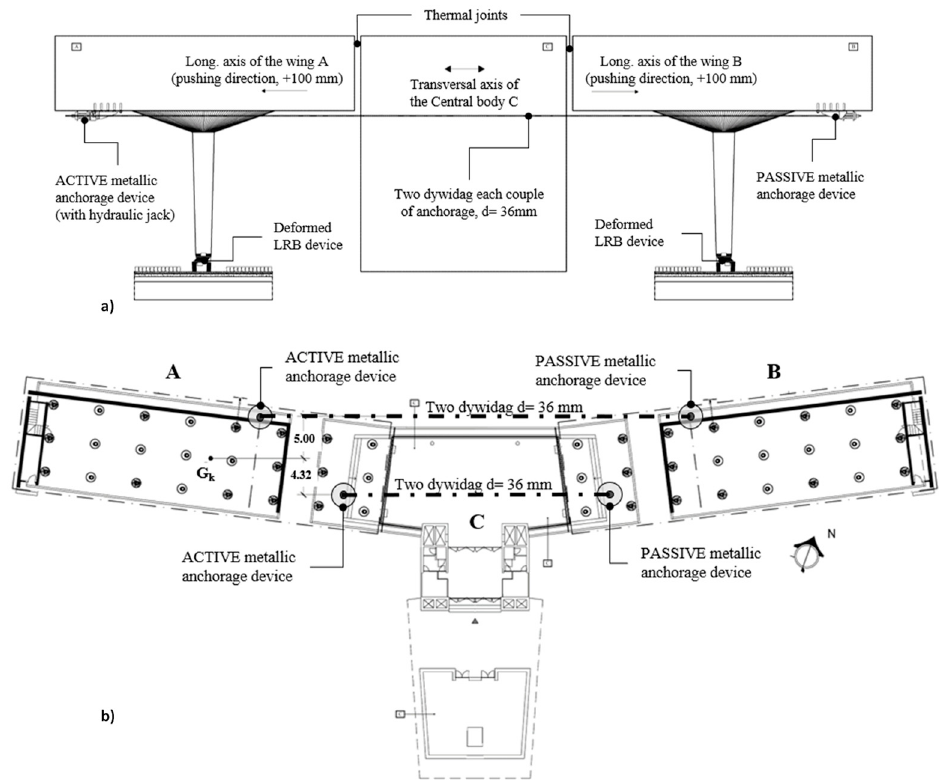
Figure 20. Schematic view of the system of cables at gradual release and the relevant components: ( a ) vertical section, and ( b ) plan view (all dimensions in m).